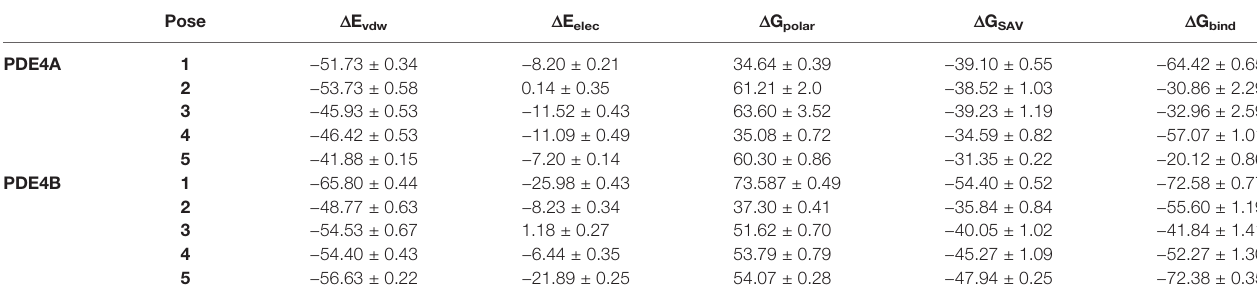
TABLE 3 | Calculated values that contributed to binding-free energy from MM/PBSA a .